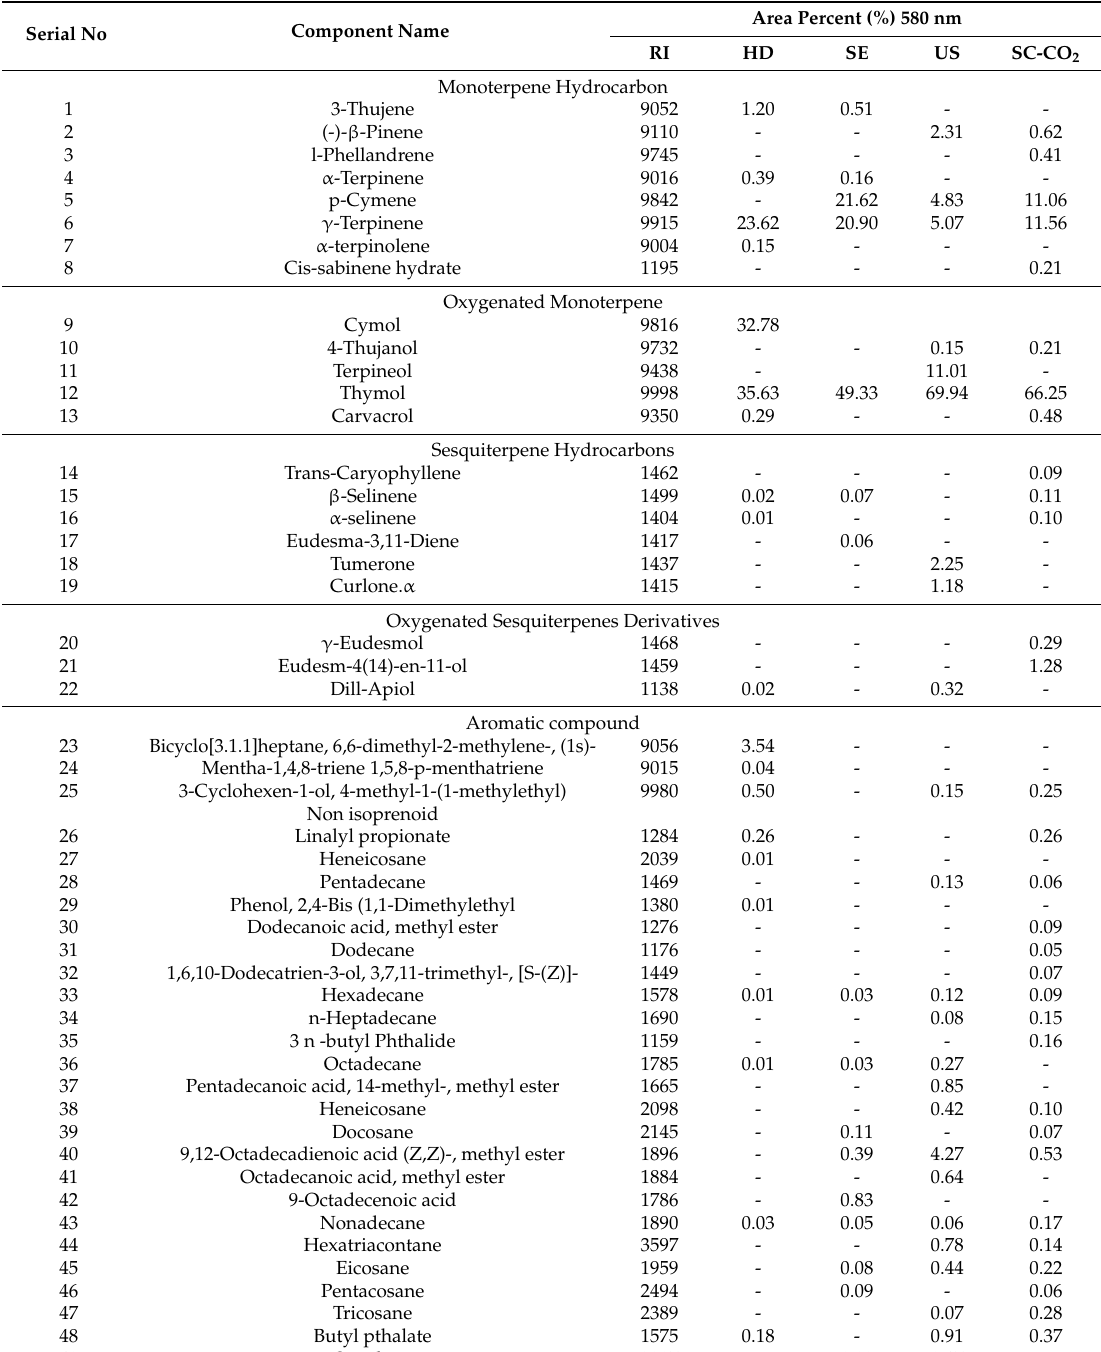
Table 5. Results of the GC-MS analysis of Tachyspermum ammi oil extracted by different techniques. Serial